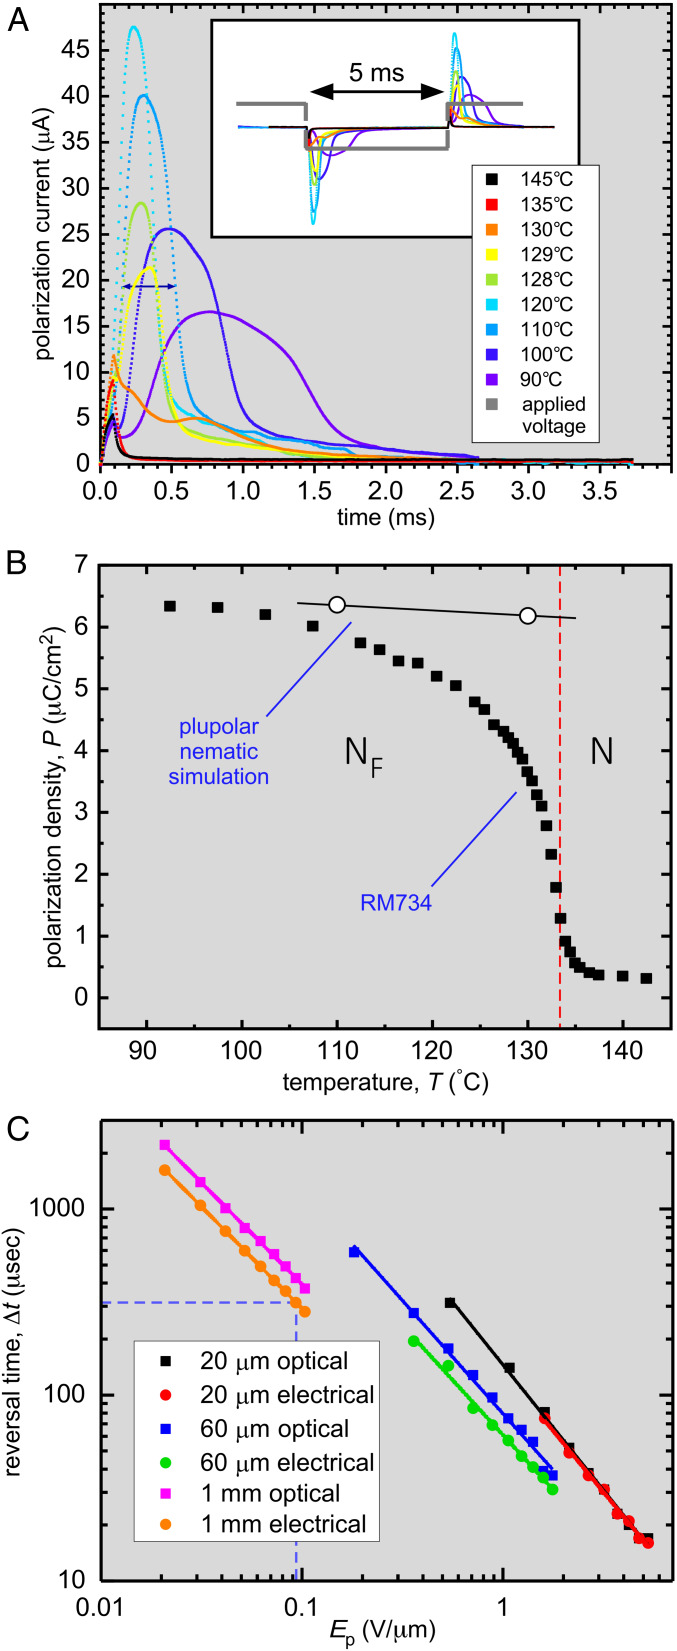
Characteristics of polarization reversal in an applied field. (A) Temperature dependence of the cell current with a 200-Hz square wave generating a field Ep = 95 V/mm applied in-plane to a t = 15-µm-thick cell with 1-cm-wide ITO electrodes spaced by d = 1 mm. In the I and N phases (T ≥ 133 °C), the current is small and capacitive. On cooling into the NF phase, an additional current contribution appears, the area of which is independent of voltage and is equal to the net polarization reversal charge, Q = 2PA, where A = 15 µm × 1 cm is the effective cross-sectional area of the volume of LC material reoriented by the applied field. In the NF phase, the polarization reversal current becomes a distinct peak that grows in area on cooling, indicative of an increasing polarization density, and the reorientation takes place more slowly, reflecting the increase of orientational viscosity. The double-headed arrow shows the reversal time at T = 110 °C (dashed drop lines in C). (B) The polarization density P of RM734 measured on cooling (black squares) saturates at P ∼6 µC/cm2 at the lowest temperatures. The open circles are values of P of the plupolar nematic calculated from the POL MD simulation of the NF phase (Fig. 7 and SI Appendix, Sections S9 and S10). In the plupolar nematic, long-wavelength orientation fluctuations are suppressed, giving a P value determined by molecular-scale fluctuations and local packing. RM734 approaches the plupolar condition at low T. The region near the transition has not been studied in detail. (C) Field dependence of the reversal time 𝛥t, taken as the full width at half-height of the polarization or optical reversal pulse following a field step in a 100-Hz, bipolar, square-pulse train of peak amplitude Ep in planar-aligned cells with in-plane electrodes spaced by d = 20 µm, 60 µm, and 1 mm at T = 110 °C. The reversal time scales as 1/Ep as expected for reorientation driven by ferroelectric torques. The dashed lines identify the measurement with Ep = 95 V/mm highlighted in A. The risetime 𝜏 = γ1/PE is ∼0.1𝛥t, giving a value of γ1 ∼0.1 Pa-s, comparable to the viscosity of 5CB at T =25 °C.